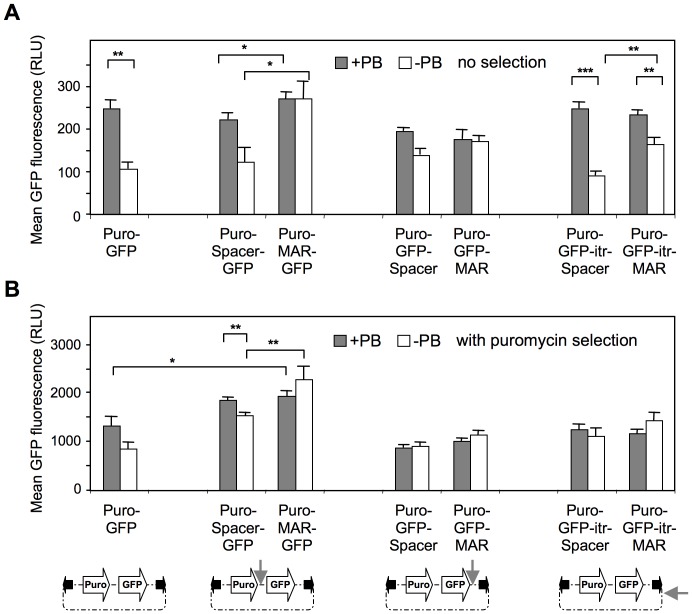
Effect of MAR on transgene expression levels.The average GFP fluorescence of the cells as described in the legend of Figure 2 was quantified by cytofluorometric analysis, either after 3 weeks of culture without selection following transfection (A), or after 2 weeks under puromycin selection (B). Values represent the means ± SEM (n = 3). *P<0.05, **P<0.01, ***P<0.001. RLU : relative light unit.